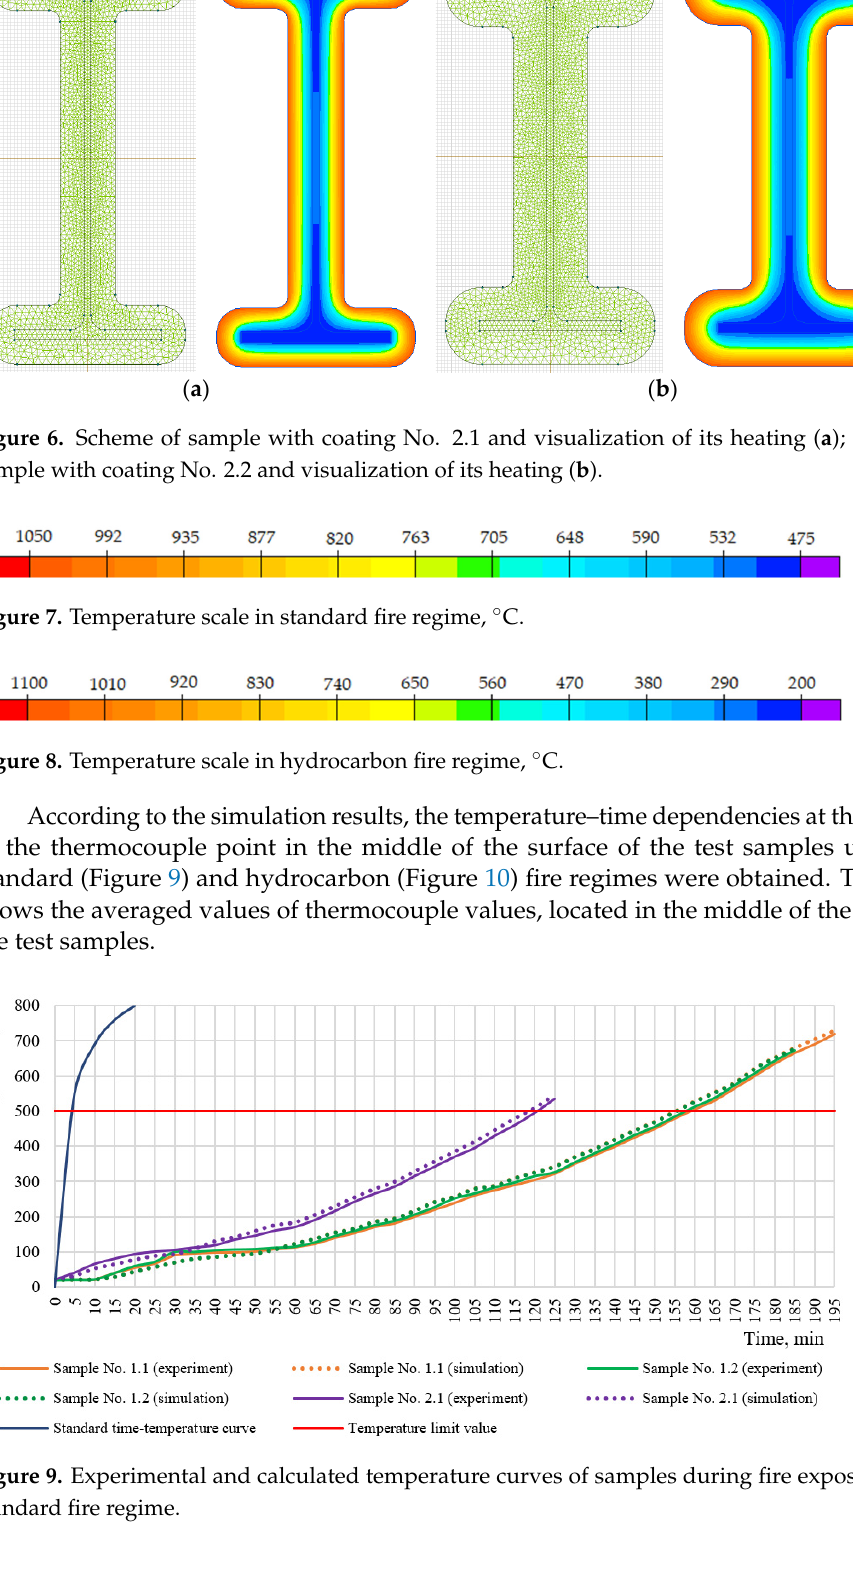
Figure 5. Scheme of samples with coatings No. 1.1–No. 1.3 and visualization of heating of sample No. 1.1 ( a ); scheme of samples with coatings No. 3.1 and No. 3.2 and visualization of their heating ( b ).